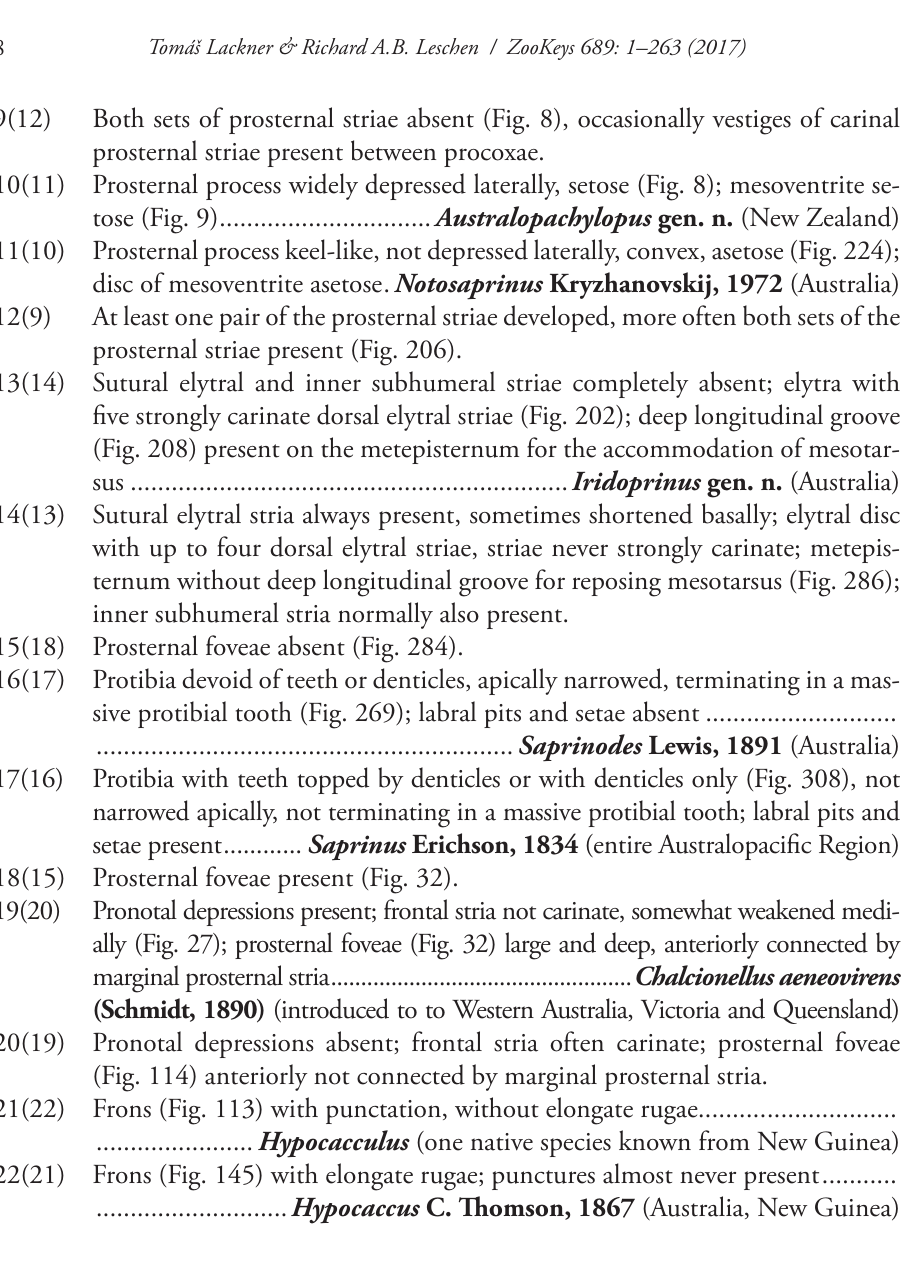
Australopachylopus gen. n. Figs 1 –25, 752 Type species. Saprinus lepidulus Broun, 1881: 665. Diagnosis. Cuticle dark brown to black with faint metallic luster; pronotum almost glabrous, only with faint scattered lateral punctation; elytra punctate